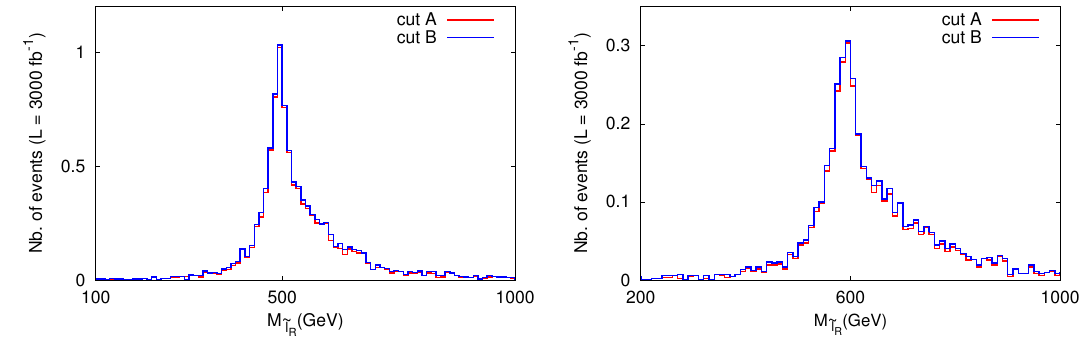
Figure 4 . Figure shows m